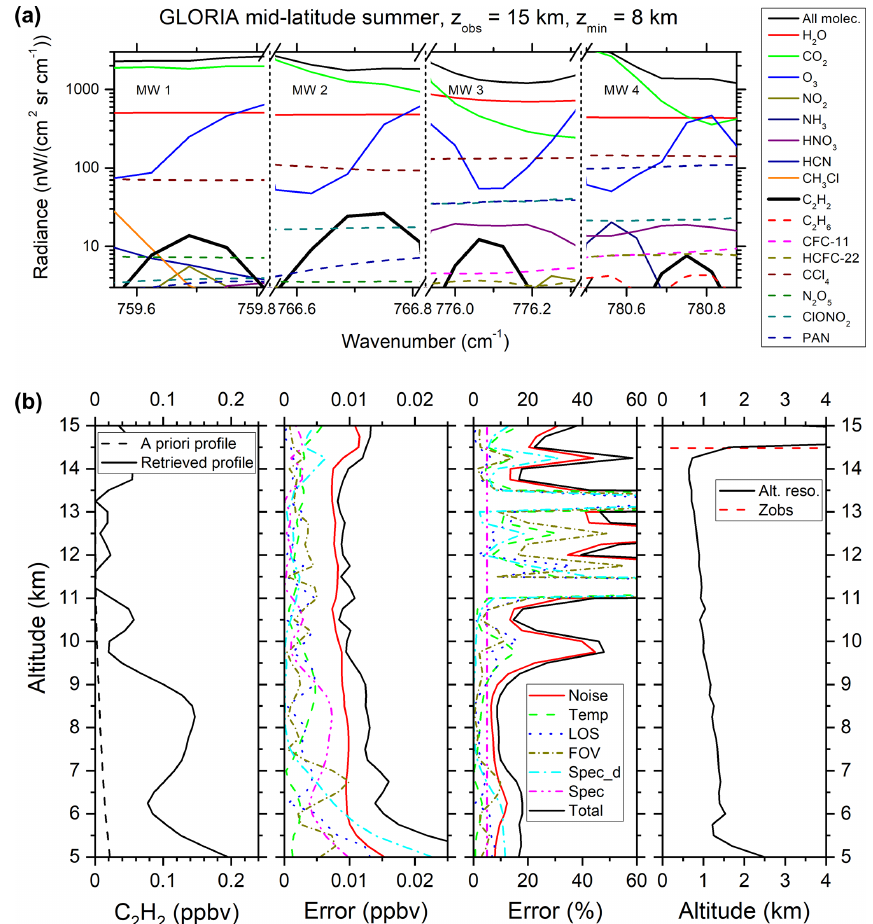
Figure 3. Simulated limb emission spectra for four microwindows within the C 2 H 2 ν 5 band centred at 730cm − 1 for a tangent altitude of 8km (a) and the error budget for a C 2 H 2 vertical profile obtained on 13 September 2017 at 16:55UTC (b) . Annotation as per Fig.